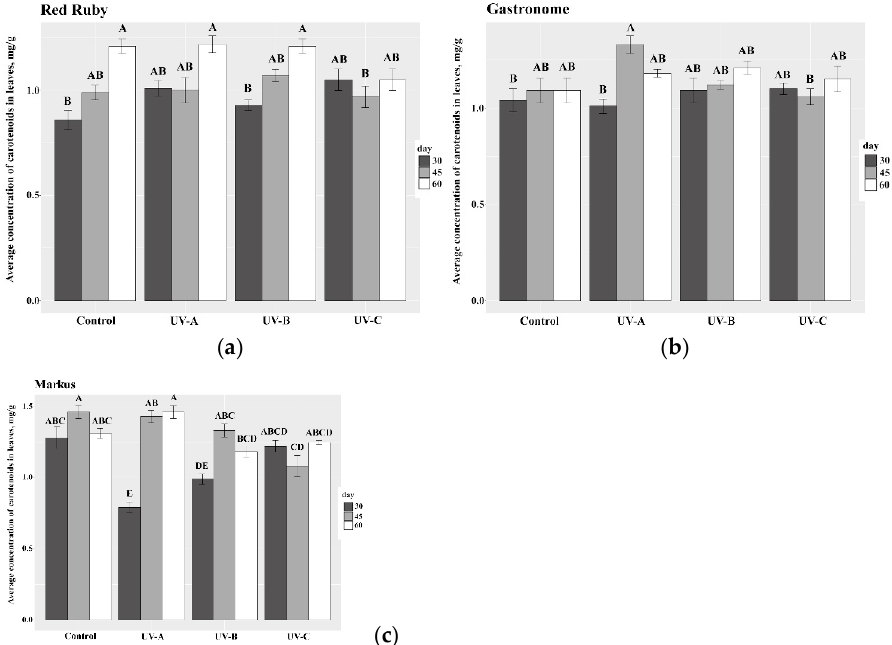
Figure 2. Average concentration of chlorophylls (a+b) in leaves, mg/g. Obtained on 30th, 45th and 60th days of cultivation of following basil varieties: “Red Ruby” ( a ), “Gastronome” ( b ) and “Markus” ( c ).